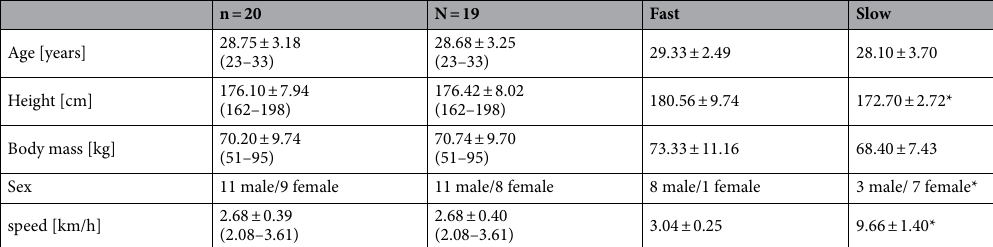
Table 1. Demographics of study participants before and after dropout of one volunteer due to an incomplete run as well as subgroups for fast (≥ 10 km/h or 2.78 m/s) and slow (< 10 km/h) runners. The subgroups differed significantly with regards to height, sex and speed (marked with *).